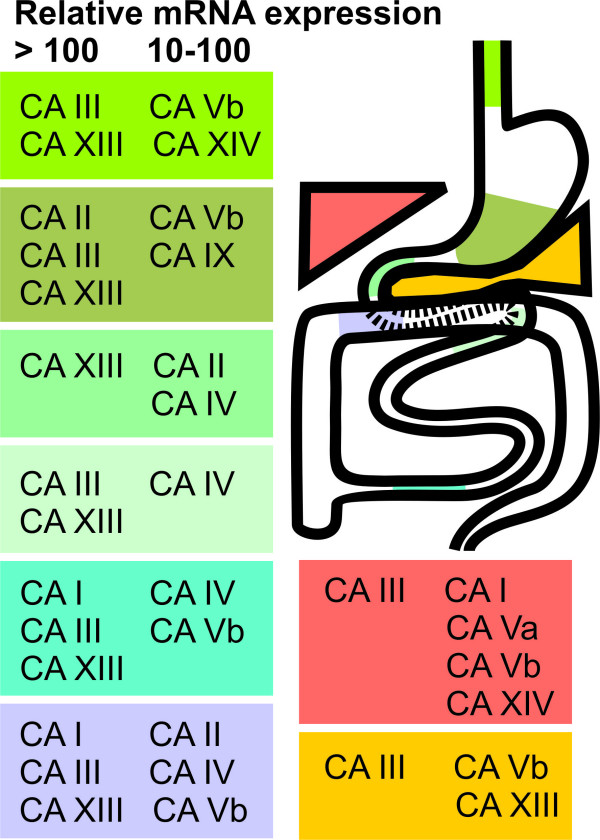
A schematic model showing relative mRNA expression levels of different CA isozymes in the gastrointestinal tract. Only the Car transcripts with moderate (relative expression value 10–100) or high expression (relative expression value >100) levels are included in the model.